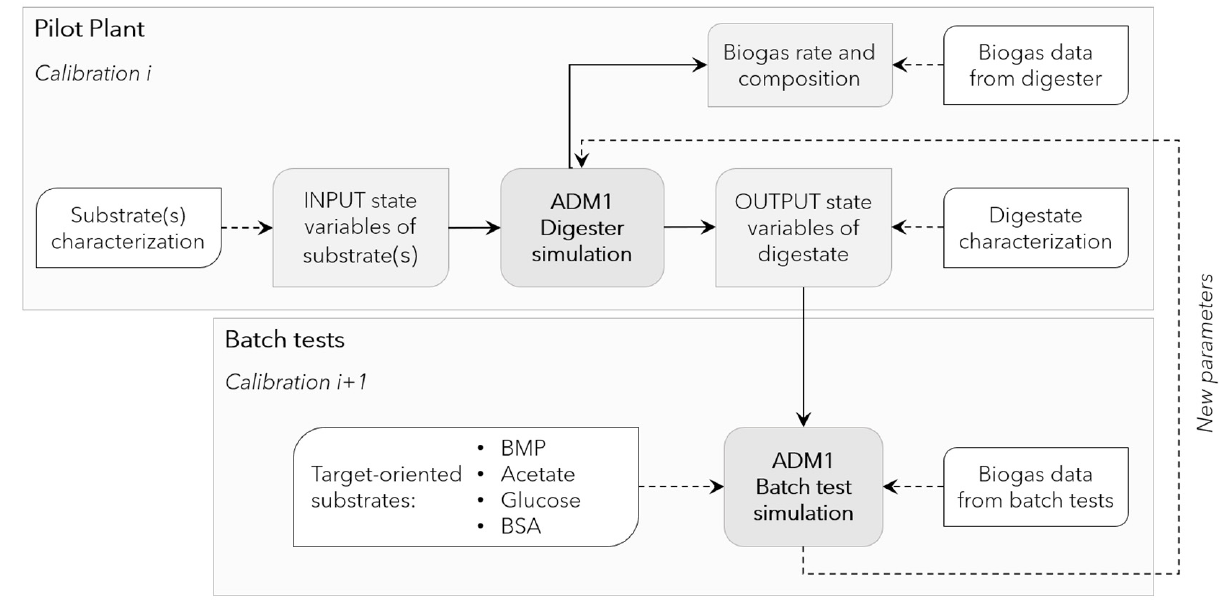
Figure 2. Outline of the iterative procedure used for model calibration, exploiting experimental data (white boxes) from the pilot plant and batch tests.